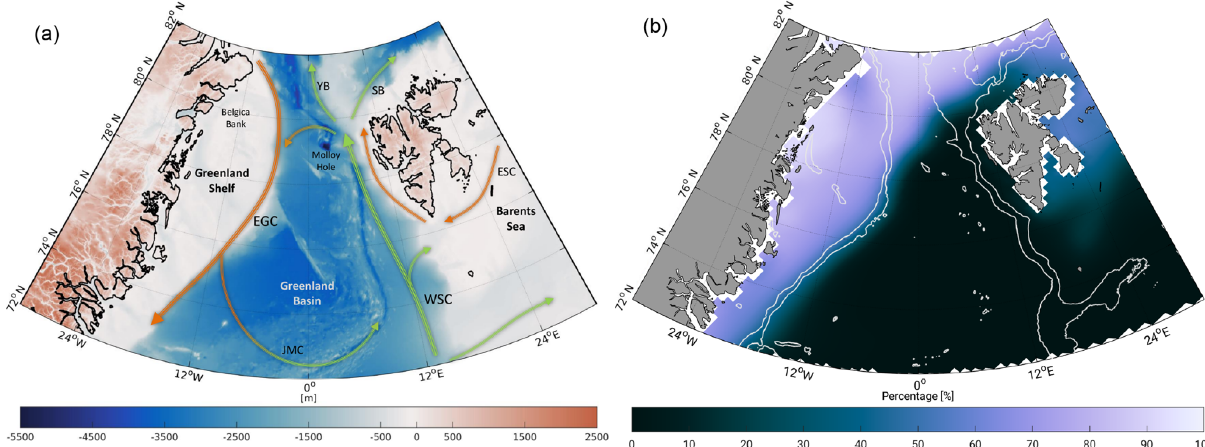
Figure 1. Overviews of the study area: (a) bathymetry of the northern Nordic seas and Fram Strait area based on RTopo2 topography model (Schaffer et al., 2016). Arrows display major current systems (East Greenland Current, EGC; West Spitsbergen Current, WSC; East Spitsbergen Current, ESC; Jan Mayen Current, JMC; Yermak Branch, YB; and Svalbard Branch, SB). Light green arrows indicate inflowing Atlantic water; orange represents fresh polar and returning Atlantic water. (b) Averaged sea ice concentration in percentage within 2003– 2009 based on 25km monthly National Snow and Ice Data Center (NSIDC, Fetterer et al., 2017) sea ice concentration grids. White lines display depth contours at − 450 and − 1500m. White areas indicate missing or flagged